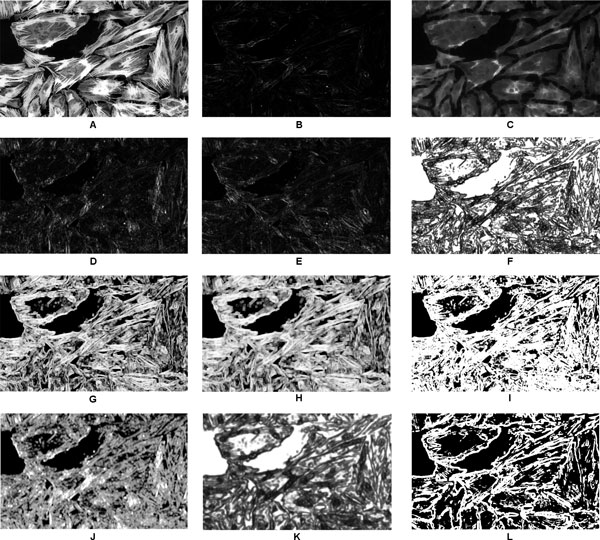
Visual representation of features used by classifiers. (a) A pre-processed image, (b) VAR3×3, (c) MIN7×7, (d) f1/4th05×5, (e) f1/4th3pi/45×5, (f) ASM5×5, (g) IMOC27×7, (h) IMOC29×9, (i) ENT5×5, (j) DOE7×7, (k) ASM9×9, and (l) outlines obtained from thresholding the output of classifier. The size of the images is 700×430 pixels.